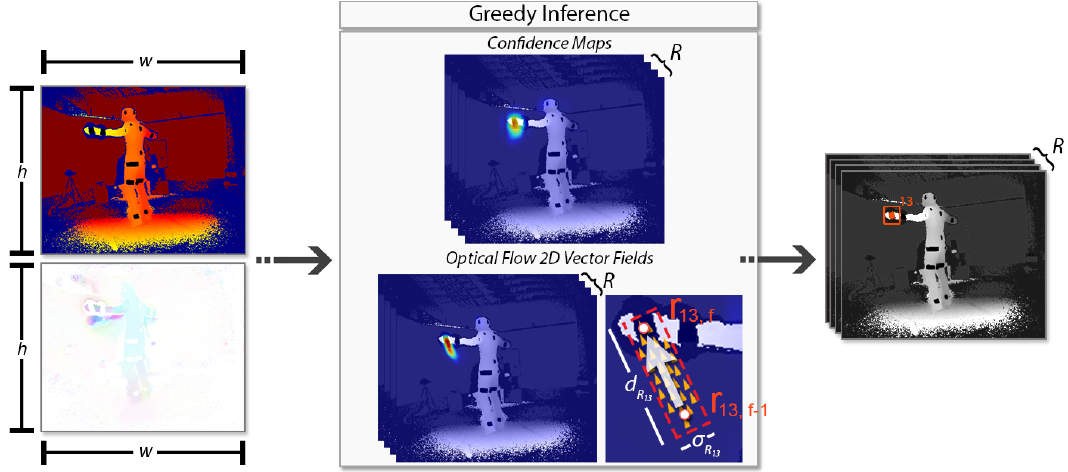
Figure 5. Overall 2D reflector-set estimation from confidence maps and optical flow 2D vector